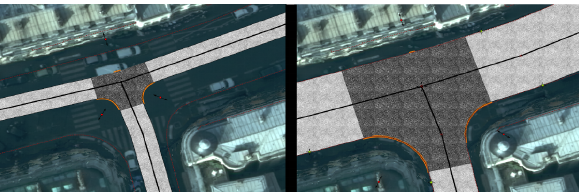
Figure 15: The estimated parameters may be far from reality